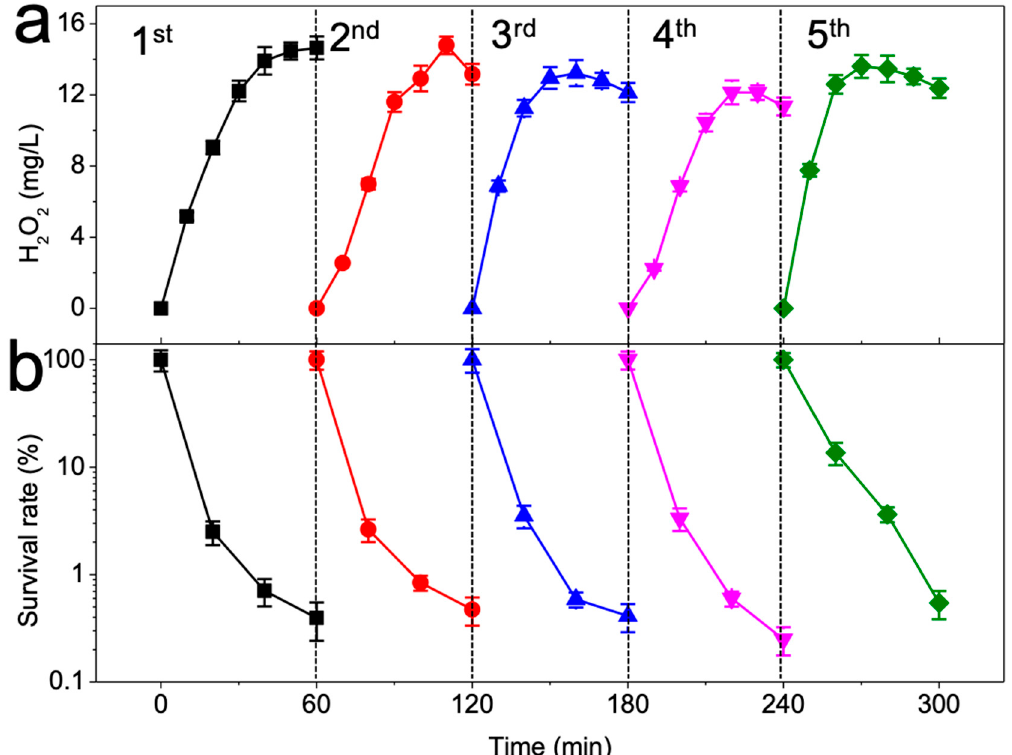
Figure7. ReusabilityofGACcathodefor( a )hydrogenperoxideproductionand( b )bacterialdisinfection. Figure 7. Reusability of GAC cathode for ( a ) hydrogen peroxide production and ( b ) bacterial Conditions: 3 g GAC as cathode under 100 mA current, 0.2 mM FeSO 4 , 10 8 CFU / mL E. coli , pH ini disinfection. Conditions: 3 g GAC as cathode under 100 mA current, 0.2 mM FeSO 4 , 10 8 CFU/mL E. coli , pH ini 7.